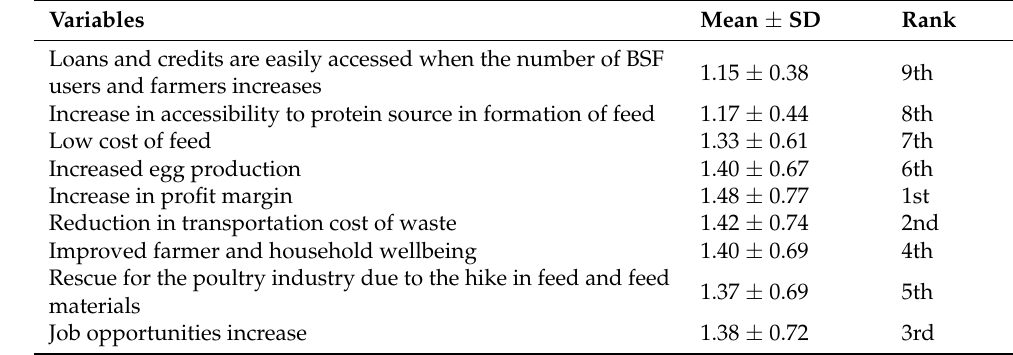
Table 2. Distribution of respondents on perceived benefits of BSF as a protein source for poultry feed in Oyo